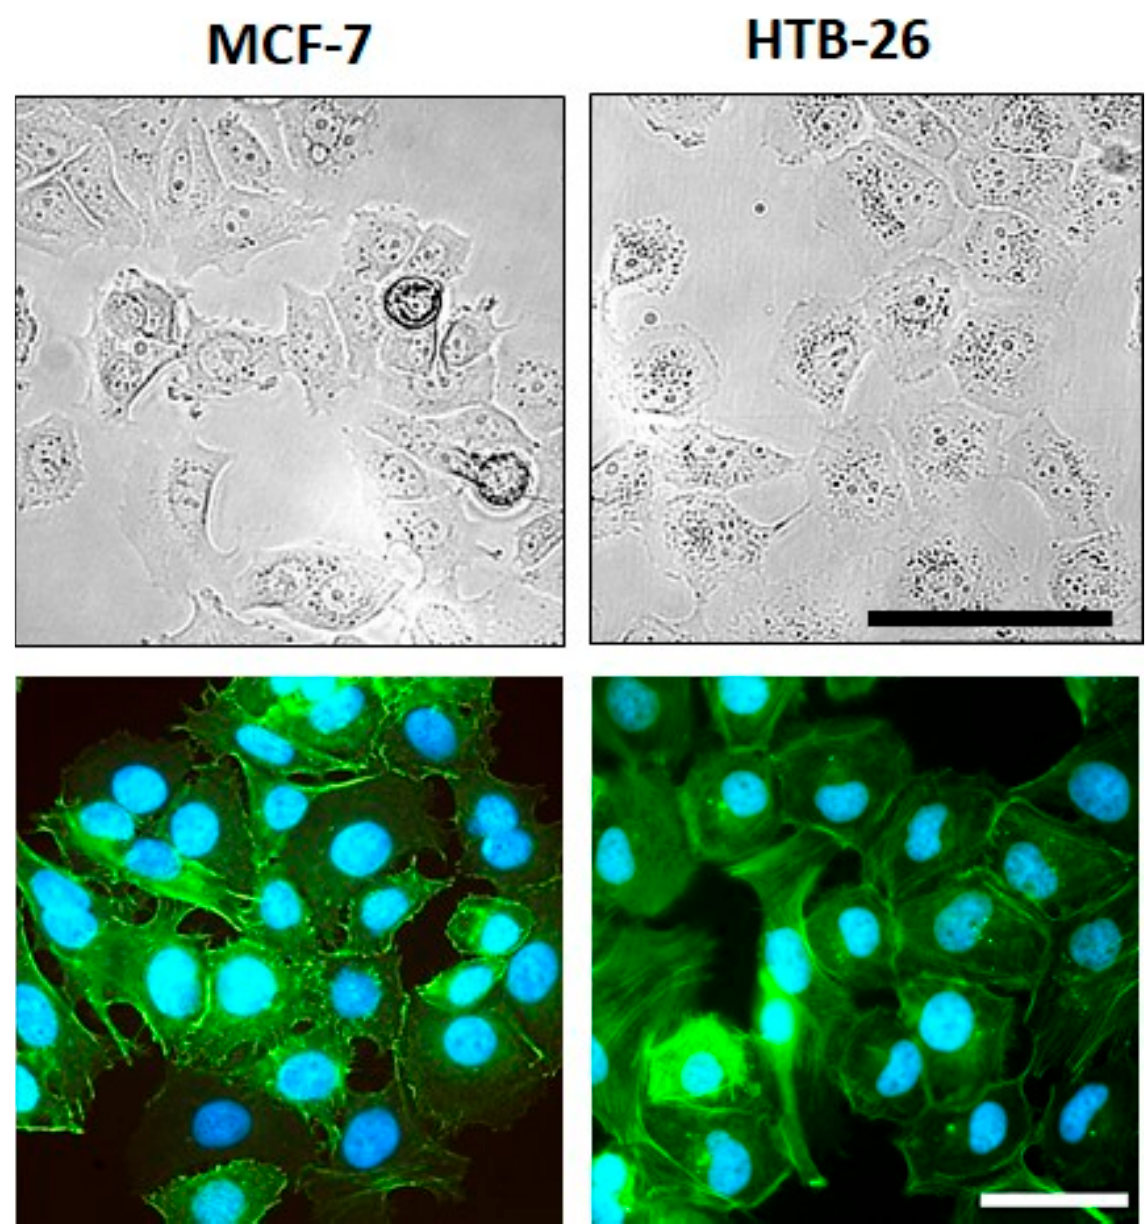
Figure 2. Morphology and F-actin organization of MCF-7 and MDA-MB-231 breast cancer cells. ( Upper row ) Representative images of the cell morphology of MCF-7 and MDA-MB-231 breast cancer cells at ~70–80% confluency in adherent culture; scale bar: 100 µ m (applies to both cell lines). ( Lower row ) Examples of fluorescence images of the F-actin organization in MCF-7 and MDA-MB-231 breast carcinoma cells; green—F-actin; blue—nuclei; scale bar: 50 µ m (applies to both cell lines). In the spheroid invasion assay, significant differences were detectable between MCF-7 and MDA-MB-231 cancer cell spheroids. MDA-MB-231 cancer cells invaded significantly deeper into the Matrigel extracellular matrix (ECM) and showed enlarged invasion areas at 24 h and 48 h compared with the MCF-7 cancer cells, which grew only slightly during the observation period (Figure 3). This effect was also observed in vivo (Figures 4 and